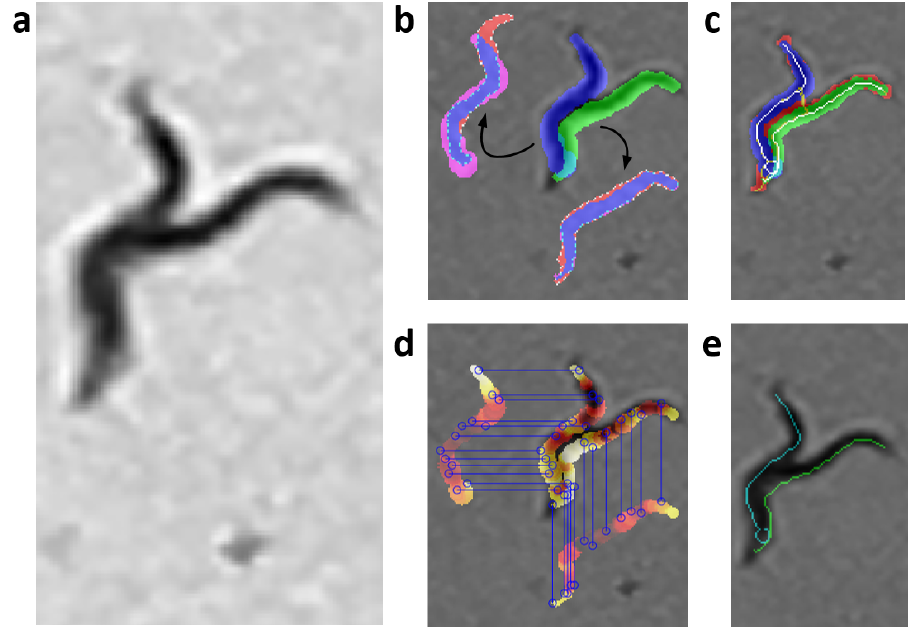
Figure A8. Model 7 evaluation, example 2. The yellow and white pixels are the resulting skeleton using the improved form of skeletonizing. The white pixels are the pixels of the skeleton prediction, which are used to reconstruct the body of each worm (segmentation in blue and green). ( a ) Grayscale image. ( b ) Overlap criterion evaluation. ( c ) Completeness criterion evaluation. ( d ) Color criterion evaluation. ( e ) Optimization